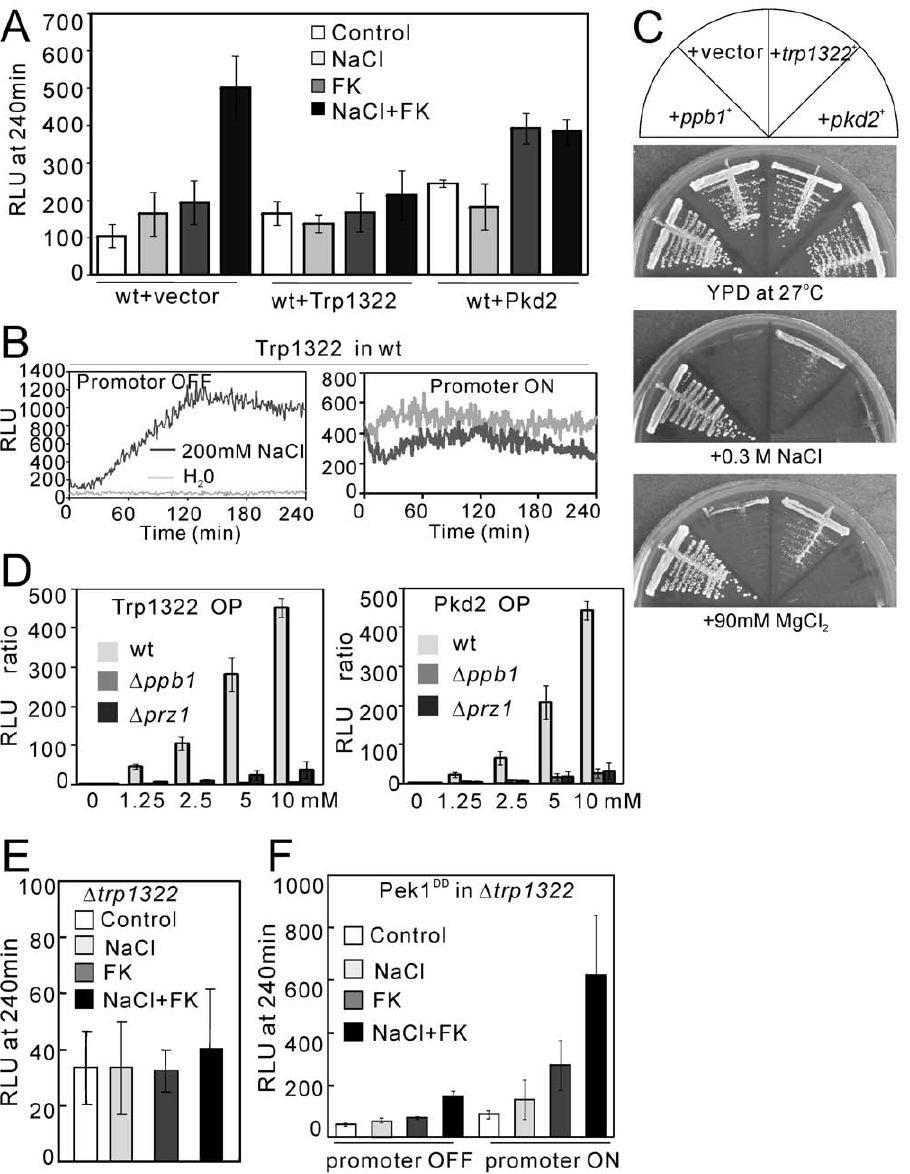
Figure 7. The role of Trp1322 in the regulation of calcium homeostasis in fission yeast. (A) The overexpression of Trp1322 and Pkd2 abolished the synergistic effect of NaCl plus FK506. The KP3028 cells were transformed with the control vector, pREP1-GFP-Trp1322 or pREP1-Pkd2- GFP, then were cultured as described in Figure 2A, and were assayed as described in Figure 4. The histogram was calculated as described in the legend of Figure 4. (B) When Trp1322 was overexpressed, the high basal CDRE-reporter activity was significantly decreased by the addition of NaCl. Note the marked activation of the reporter activity by the same stimuli in non-induced cells (Promoter OFF, left pannel). The KP2755 ( h 2 leu1 arg1 3 6 CDRE::luc(R2.2):: arg1 + ) cells were transformed with pREP1-GFP-Trp1322. The assay was performed as described in Figure 3B. The data shown are representative of multiple experiments. (C) The overexpression of trp1322 + gene suppressed the salts sensitivity of D ppb1 cells. The D ppb1 cells transformed with the control vector, pREP1-GFP-Trp1322 or pREP1-Pkd2-GFP were streaked onto the plates as indicated and then incubated for 4 days at 27 u C. (D) The effect of the overexpression of Pkd2 or Trp1322 on the cytosolic Ca 2 + level upon the addition of extracellular calcium in D ppb1 and D prz1 cells. The KP3028 (wild-type), KP3750 ( D ppb1 ) or KP3688 ( D prz1 ) cells transformed with the control vector, pREP1-GFP-Trp1322 or pREP1- Pkd2-GFP, respectively were cultured and assayed as described in Figure 2A. The RLU ratio was determined by dividing the peak RLU at 0 mM CaCl 2 by the peak RLU at 1.25, 2.5, 5, and 10 mM CaCl 2 , respectively. The data represent the means 6 standard deviations of RLU ratio from three independent experiments, and each sample was analyzed in duplicate. (E) The deletion of trp1322 + gene suppressed the synergistic effect of NaCl plus FK506. The D trp1322 cells harboring pKB6892 were cultured and assayed as described in Figure 4. The histogram was calculated as described in the legend of Figure 4. The data represent the means 6 standard deviations of RLU taken at 240 min from three independent experiments, and each sample was analyzed in duplicate. (F) Overexpression of the constitutively active Pek1 MAPKK also stimulates Ca 2 + influx in D trp1322 cells. The D trp1322 cells integrated with the chromosomal pREP1-GST-Pek1 DD were transformed with pKB6892, and the transformants were cultured in EMM with the addition of 4 m M thiamine for 12 hours. Then the assay was performed as described in the legend of Figure 5D. The histogram was calculated as described in the legend of Figure 4. The data represent the means 6 standard deviations of RLU taken at 240 min from three independent experiments, and each sample was analyzed in duplicate.